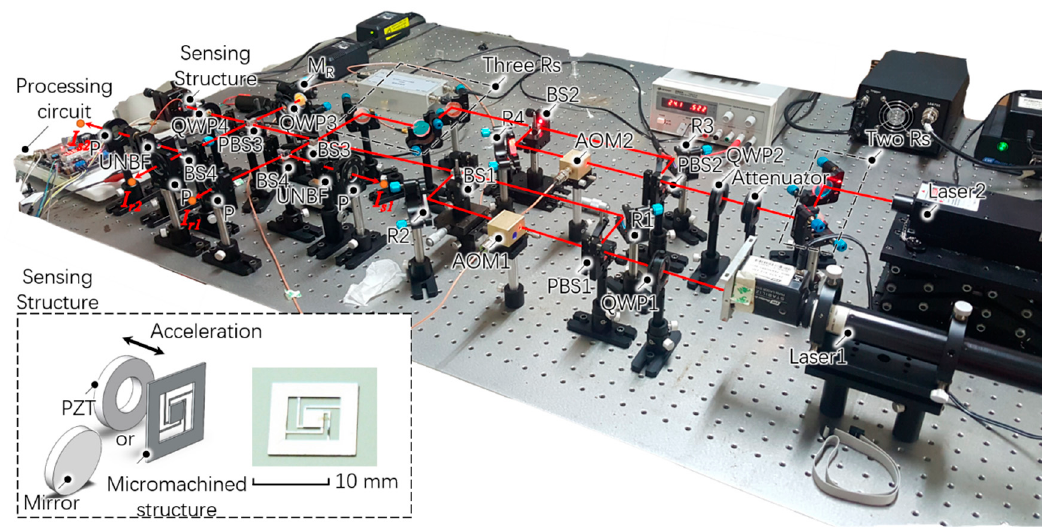
Figure 4. Prototype for the optical acceleration measurement configured in this investigation. Inset: sketch of the sensing structure, which contains a ring piezoelectric transducer and a micromachined structure or a mirror.